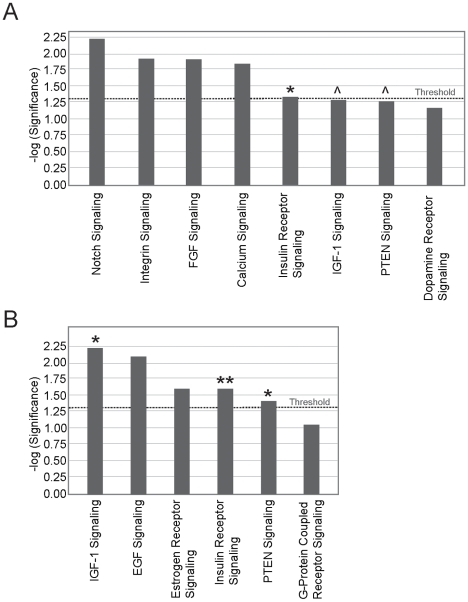
Significantly changed canonical pathways in PSP brain.
Figure 3A. Significantly changed canonical pathways in PSP brain in the uncorrected dataset. Threshold for significance is shown in the dotted line. * signifies the significantly deregulated (p = 0.047) Insulin Receptor Signalling pathway and ^ signifies the almost significantly deregulated (p = 0.051 and p = 0.055) IGF-1 and PTEN Signalling pathways respectively. Figure 3B. Significantly changed canonical pathways in PSP brain in the corrected dataset. Threshold for significance is shown in the dotted line. ** signifies the significantly deregulated (p = 0.025) Insulin Receptor Signalling pathway for both analysis and * signifies the significantly deregulated (p = 0.006 and p = 0.039) IGF-1 and PTEN Signalling pathways, respectively.